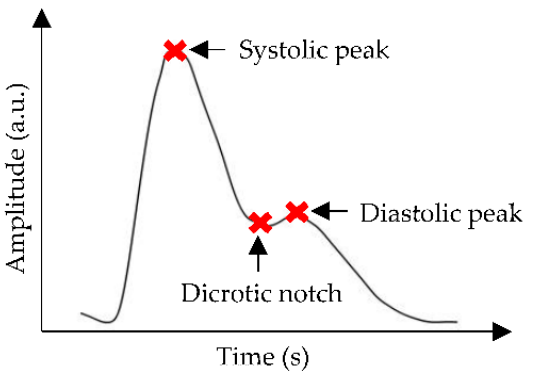
Figure 2. A common representation of PPG waveform, where the red cross marks show systolic peak, dicrotic notch, and diastolic peak points.